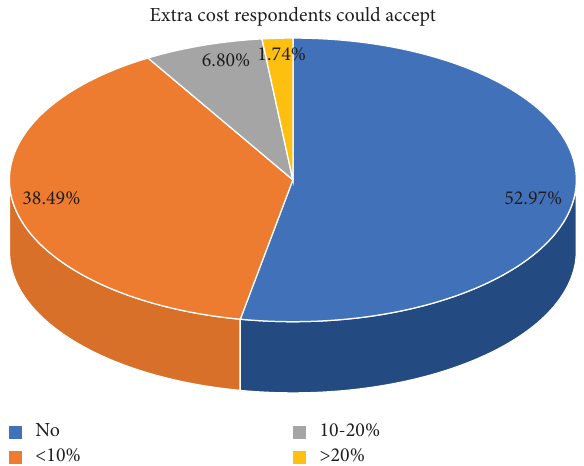
Figure 2: Percentage of respondents according to acceptable in- crease in cost for ADV service.